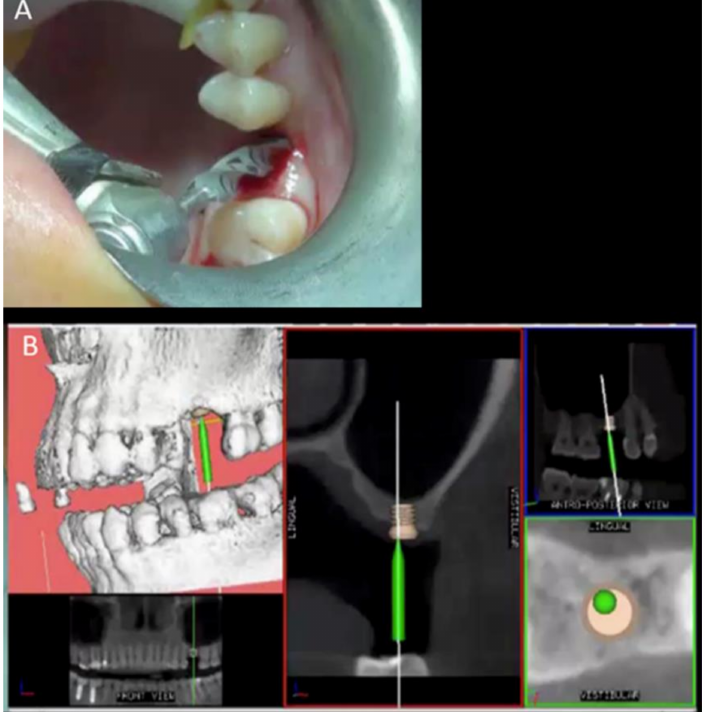
Figure 3. Clinical view of the implant site preparation ( A ) and the screen view showing the final implant digital position, and the green pin representing the working burr superimposed on the 3D radiologic anatomy ( B